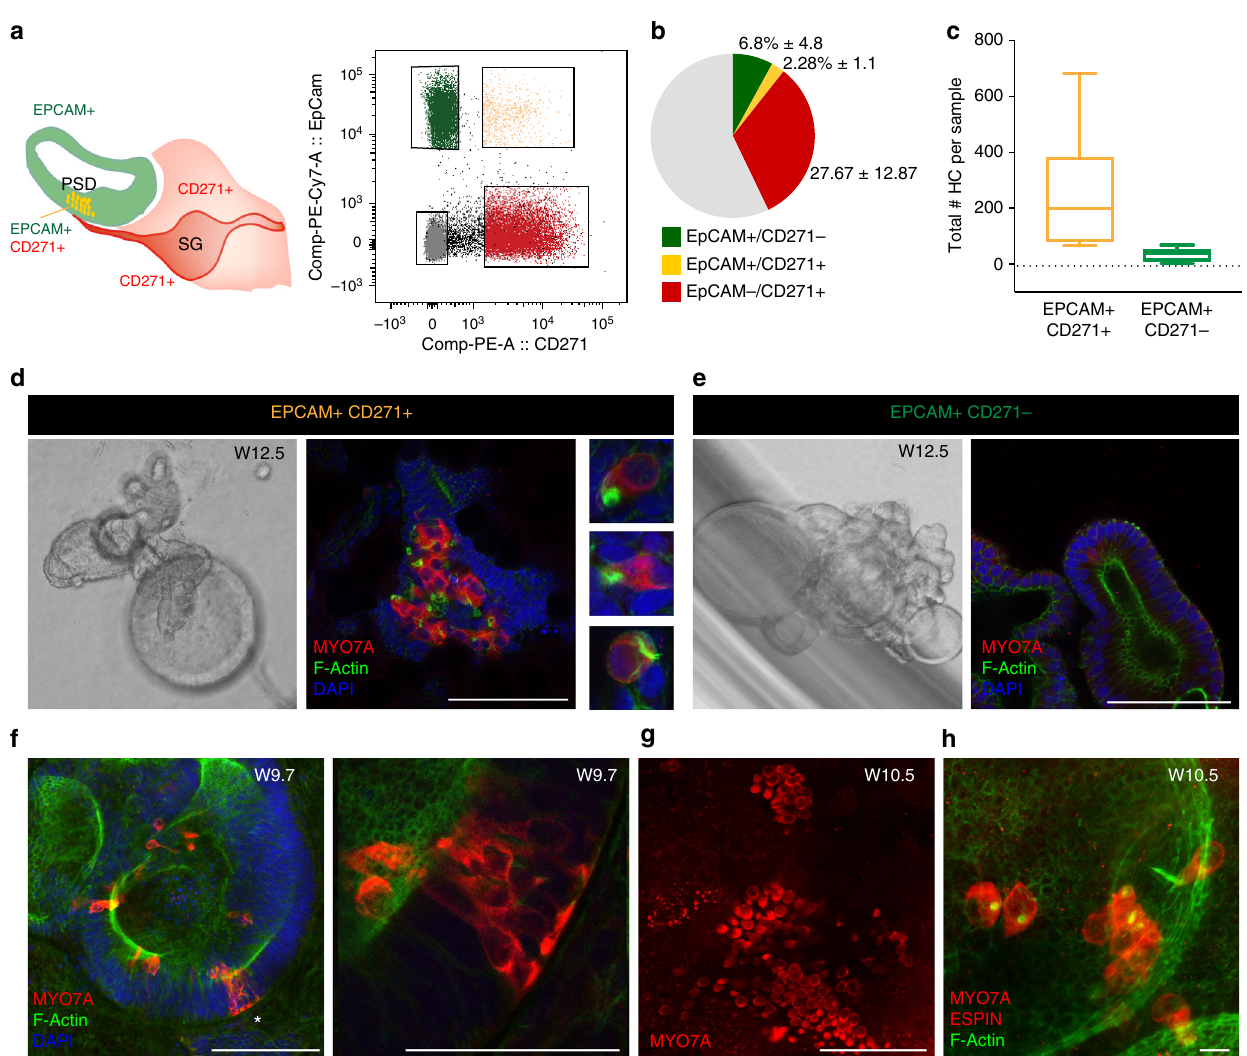
Fig. 6 EPCAM + /CD271 + cells are hair cell progenitors. a Schematic illustration of EPCAM and CD271 expression in the cochlear duct. Double-positive cells in the PSD are shown in yellow. FACS plot showing the gated populations from a W12 sample (E1242). b Pie chart illustrating the distribution of the four FACS-sorted populations. n = 8 fetal tissues (week 9.4 to 12.3). Values are mean percent ± s.d. c Quanti fi cation of the total number of hair cells-like cell (HC) per sample obtained from the two sorted populations ( N = 5 samples: W9.7 (E1238), W10.5 (E1270), W12.5 (E1242), W11 (E1254), and W12 (E1289)). EPCAM + /CD271 + cells: N = 19 organoids; EPCAM + /CD271 − cells: n = 47 organoids.. Box plot indicates distribution, middle line: median, whiskers: minimum and maximum. d Representative examples of organoids derived from EPCAM + /CD271 + and e EPCAM + /CD271 − populations (W12 sample, E1242). Immunostaining for MYO7A and co-staining with phalloidin and DAPI is shown. Selected hair cells-like cell morphologies from the 3D stack are shown in d . Scale bars = 100 μ m. f Organoid derived from EPCAM + /CD271 + cells from a W9.7 sample (E1238) stained for MYO7A, F-actin and DAPI. Scale bar 100 μ m. The area marked by the asterisk is enlarged in the right panel. g Organoid derived from EPCAM + /CD271 + cells from a W10.5 sample (E1270) immunostained for MYO7A. Scale bar = 100 μ m. The same organoid is shown at higher magni fi cation in h . h The sample is re- stained for ESPIN (red) and F-actin. Scale bar 10 μ